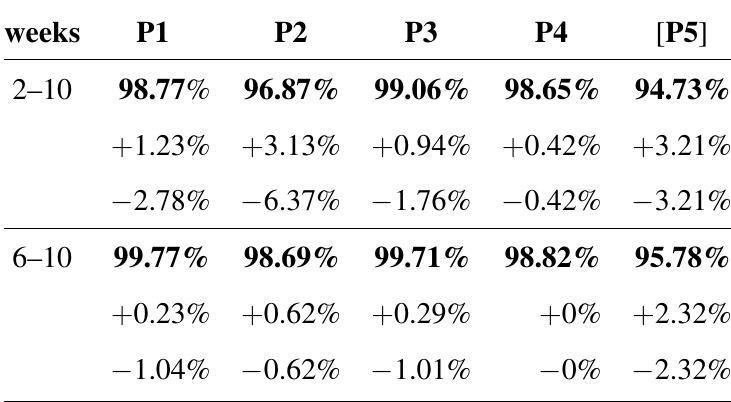
Table 2. Mean F -measure values for the denoted period applying the twofold 2 standard